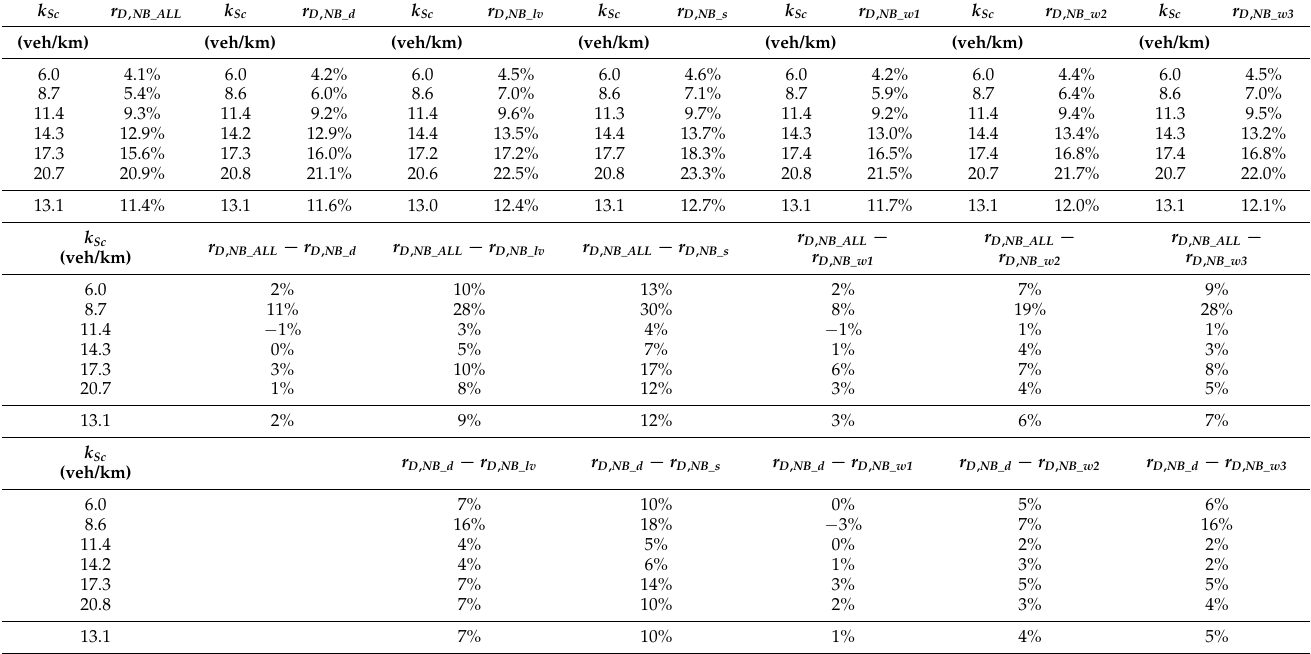
Table 1. Relative delays of vehicles depending on traffic density for simulation scenarios NB_ALL and NB_c , along with relative differences for the “average”